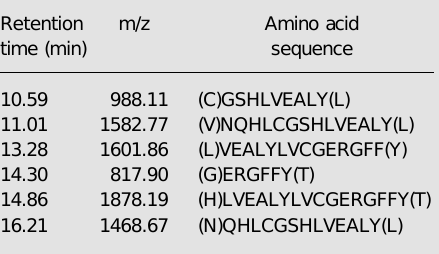
Table 1. Fragments observed during the proteolysis of ß-chain insulin by ZapA detected and sequenced by electrospray mass